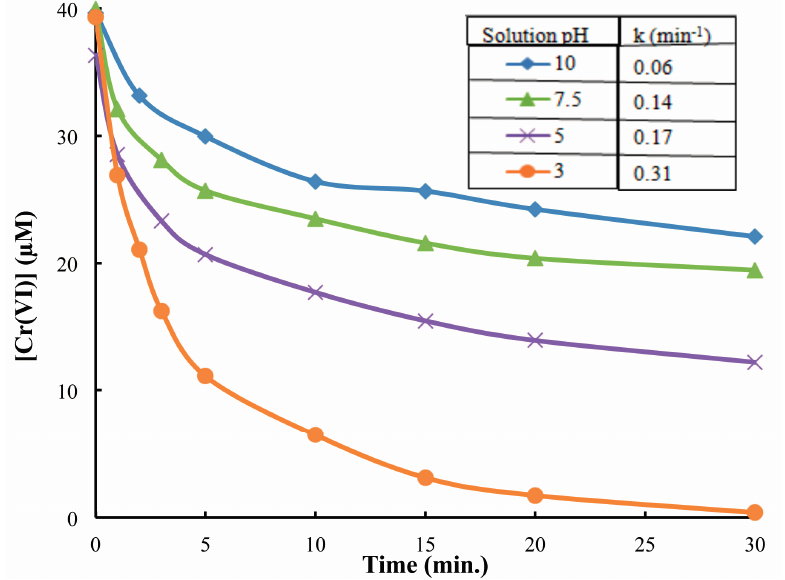
Figure 2. Investigation of reaction kinetics of Cr(VI) reduction as a function of solution